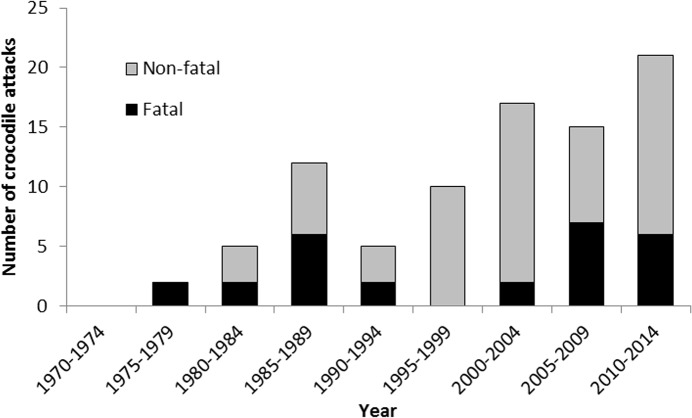
Number of fatal and non-fatal attacks by Crocodylus porosus divided into 5-year periods between 1970 and 2014 in Australia.